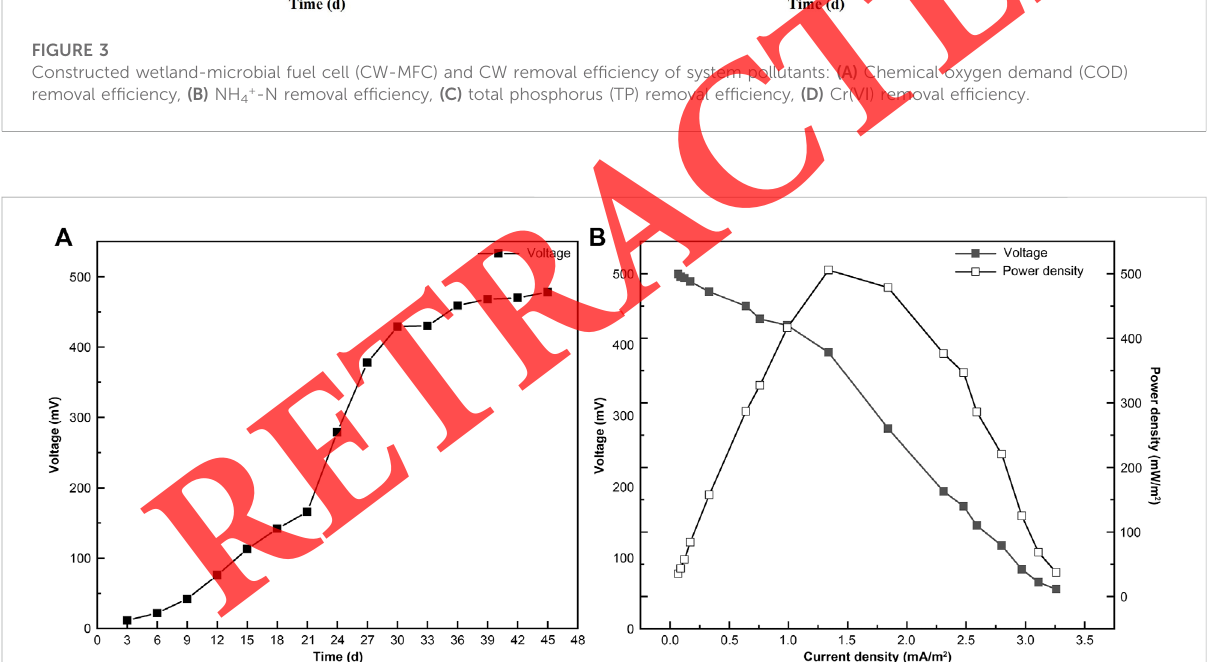
Constructed wetland-microbial fuel cell (CW-MFC) and CW removal ef fi ciency of system pollutants: (A) Chemical oxygen demand (COD) removal ef fi ciency, (B) NH 4 + -N removal ef fi ciency, (C) total phosphorus (TP) removal ef fi ciency, (D) Cr( Ⅵ ) removal ef fi ciency.